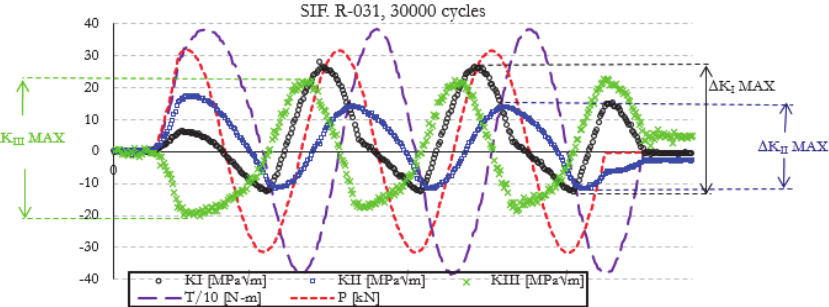
Figure 3: All mode SIF variations, ranges and applied loads as calculated from the COD method after 30,000 load cycles for a crack sizing 9.28 mm for specimen R-031 under (90 o ) out-of-phase alternated axial-torsional load